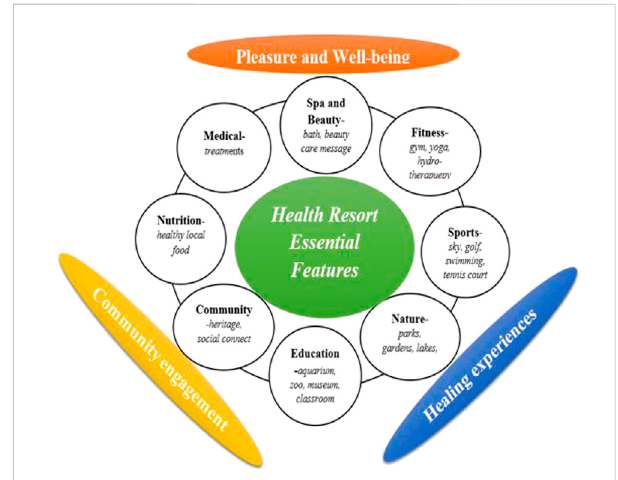
FIGURE 3 List of essential features/facilities of health resort; Source: Ekhaese and Ndimako